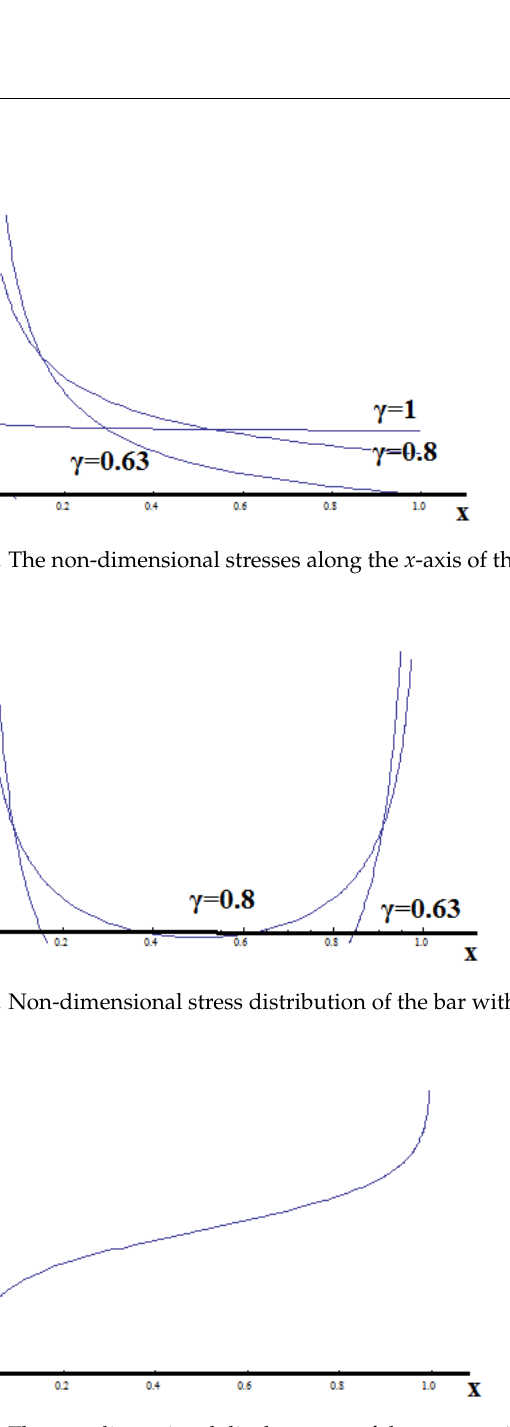
Figure 8. The non-dimensional displacement of the symmetric fractional fractal bar of order γ = 0.63.